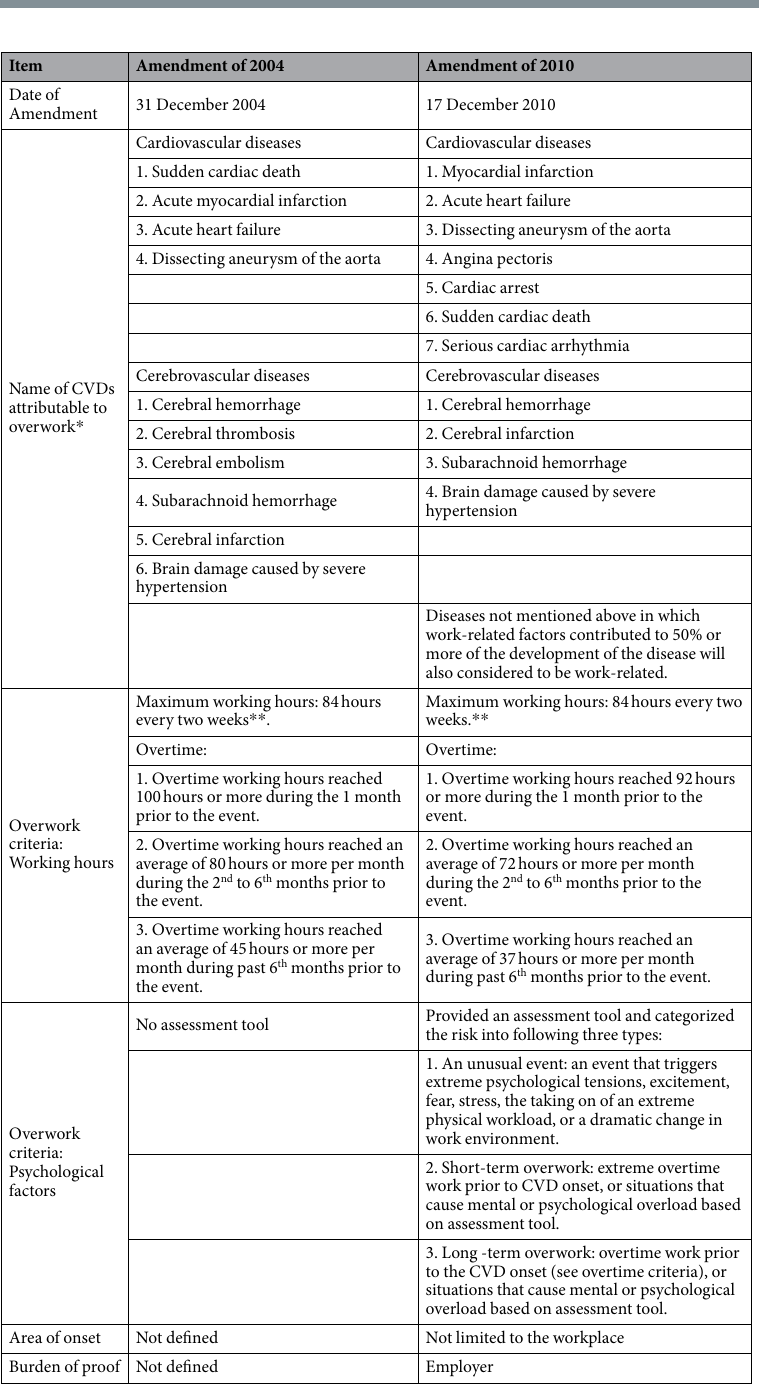
Table 1. Comparison of major changes in recognition criteria for overwork-related cardiovascular and cerebrovascular and cerebrovascular diseases (CVDs) in Taiwan. * A disease in which more than 50% of the risk of development of the disease is attributable to non-work-related factors will not be considered a work-related disease. ** On January 1, 2016, the Labor Standards Act was amended to cut the former maximum work limit of 84 hours every two weeks to 40 hours per